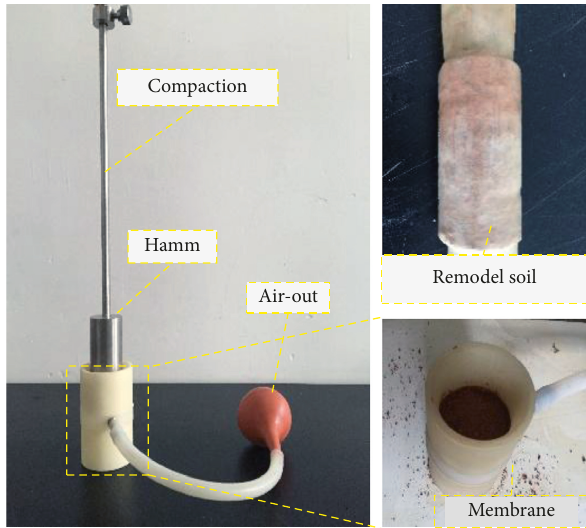
Figure 1: Manufacturing process of remodeling soil specimens.